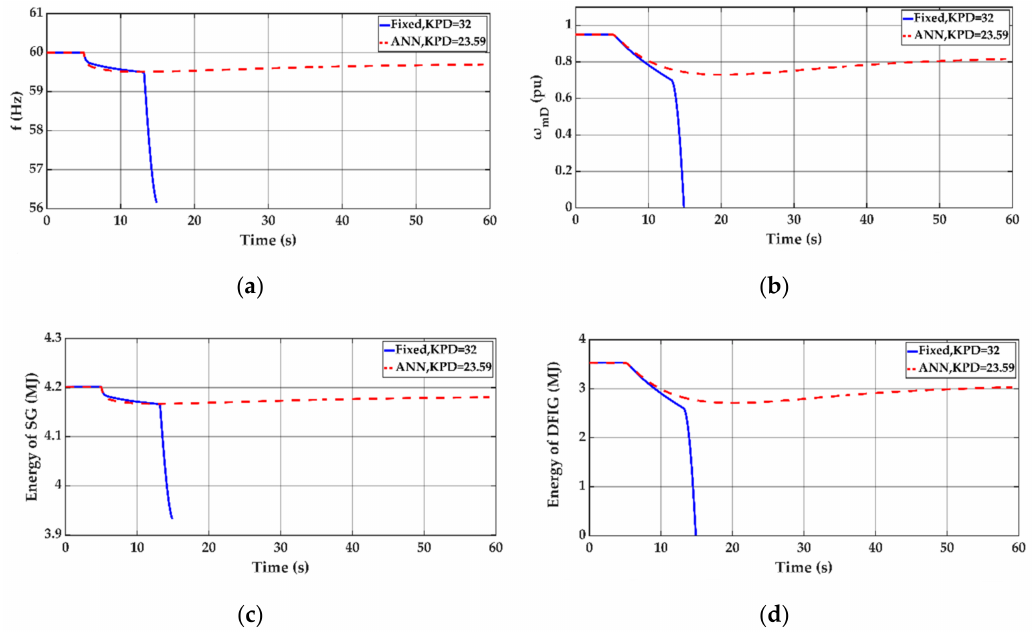
Figure 11. Dynamic response curves from the ANN-based controller and fixed-gain controller ( ∆ P Load = 62 MW, wind penetration = 29.4%, and V = 11 m / s). ( a ) Frequency, ( b ) DFIG speed, ( c ) SG energy, W and ( d ) DFIG energy.